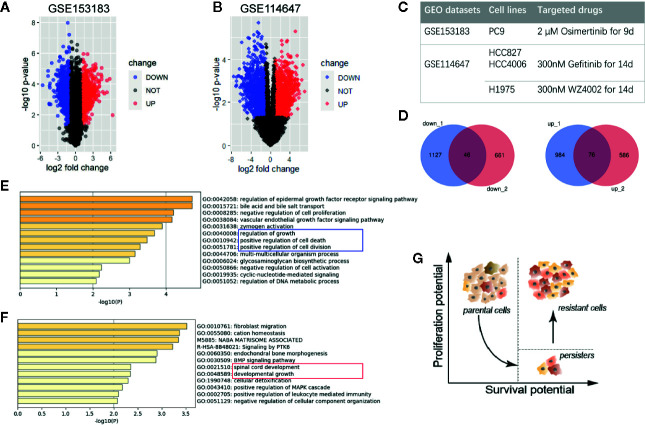
Differentially expressed genes of drug-tolerant persister cells (DTP) in NSCLC. (A, B) Volcano plots of GSE153183 and GSE114647. Blue/red plots indicate the down-regulated/upregulated DEGs with the cut-off criteria: |log2FC|>1 and p value <0.05. (C) Experimental design of two GEO datasets involved in this study. Approaches to construct DTP modules including NSCLC cell lines and target drug treatment are presented. (D) Overlapped down-regulated and upregulated DEGs as Venn diagrams shown. (E, F) Functional enrichment analysis of down-regulated and upregulated DEGs, colored by p-value. (G) Schematic diagram of phenotypical transition in cytotoxic drug therapy, representing the evolution of proliferation and survival potential from parental cells to DTPs and the eventual tumor repopulation (resistant cells). DEG, differentially expressed gene; DTP, drug-tolerant persister cell; NSCLC, non-small-cell lung cancer.